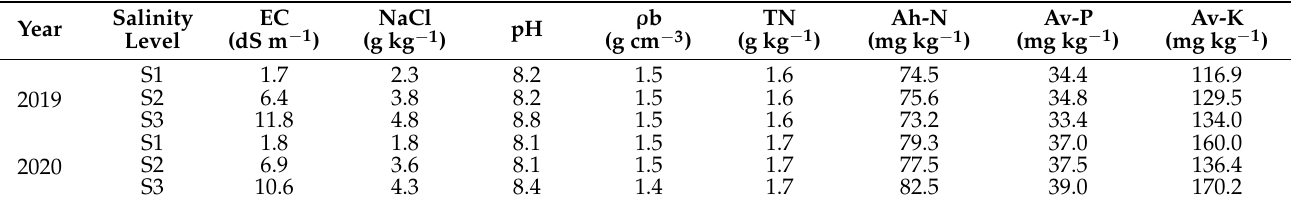
Table 1. Physical and chemical properties of the soils in 2019 and 2020.